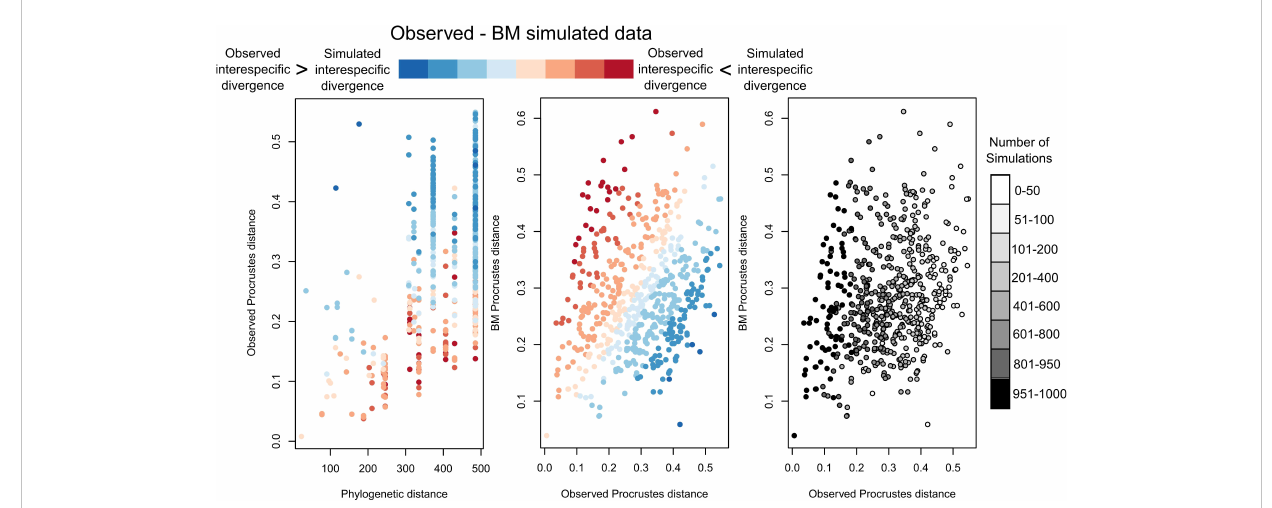
FIGURE 5 Pairwise distance-contrast plots. Red and blue colour scale was set from the difference between observed Procrustes distances and simulated distances under the Brownian motion model, while grey-scale colouration was set based on the number of simulations presenting lower observed Procrustes distances than the ones simulated under Brownian motion model.